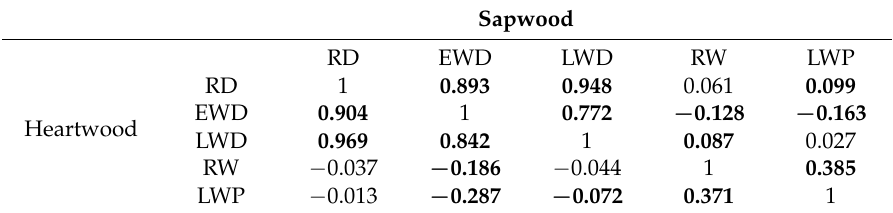
Table 6. Correlation matrix (Pearson bivariate) for ring width and density components within the heartwood (lower triangle, n = 1200) and sapwood rings (upper triangle, n = 800) (RD, ring density; EWD, earlywood density; LWD, latewood density; RW, ring width; and LWP, latewood percentage). Sapwood